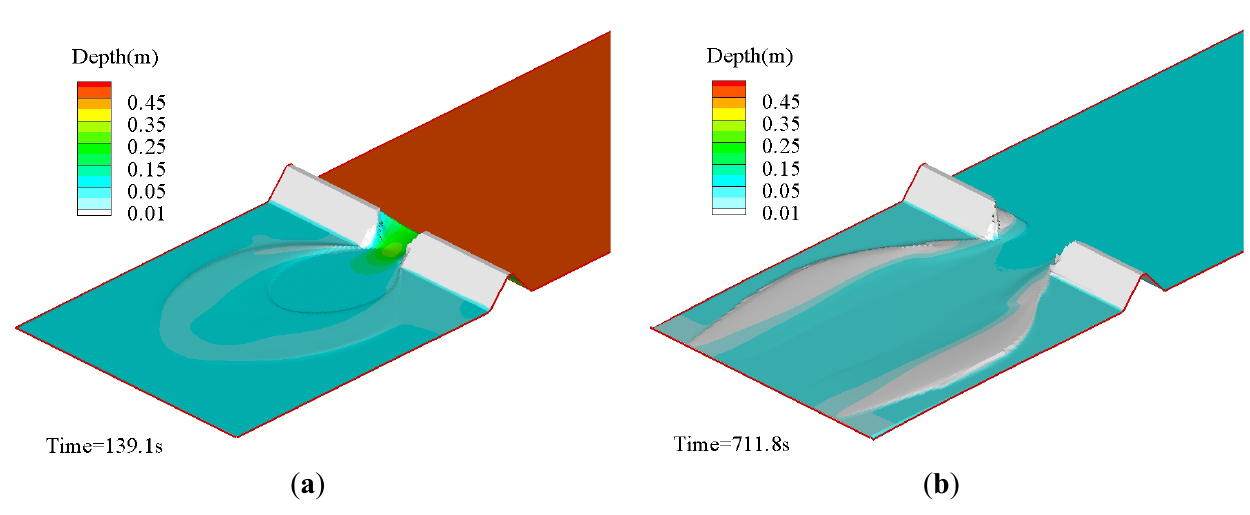
Figure 11. Bed changes and water depth with no wave at different times. The simulated water depths are plotted in the colored contours in the 3D topography view. The simulated changes of bed elevation and breach width and depth can be seen from ( a ) 139 s and ( b ) 712